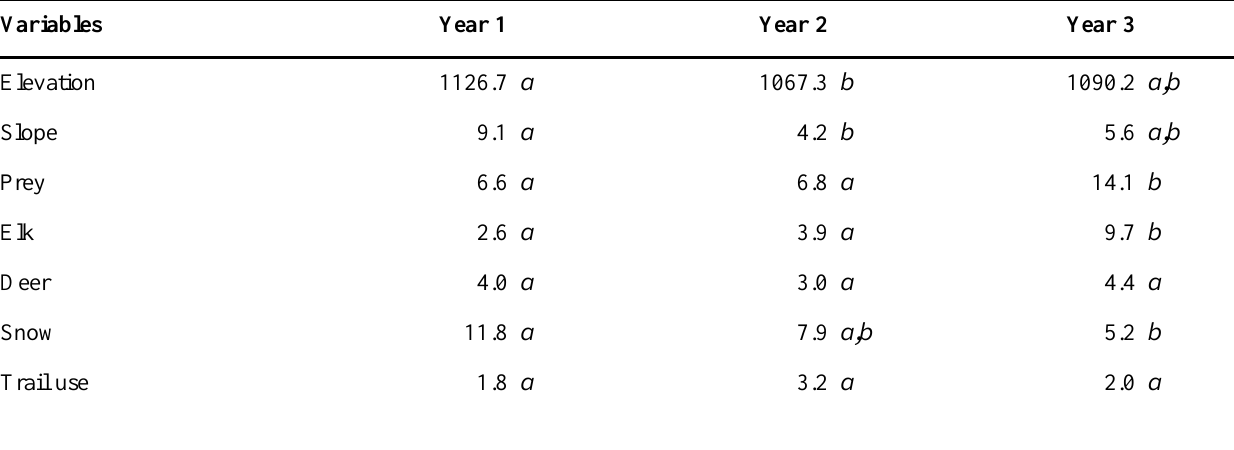
Table 2. Mean value of resources used by wolves in each year of the study. Comparisons among years were made using randomized ANOVA blocked by track with 10,000 replicates. Post-hoc tests used Bonferroni adjusted P -values and a critical P -value of 0.017. Identical letter symbols (a or b) indicate that means are similar among